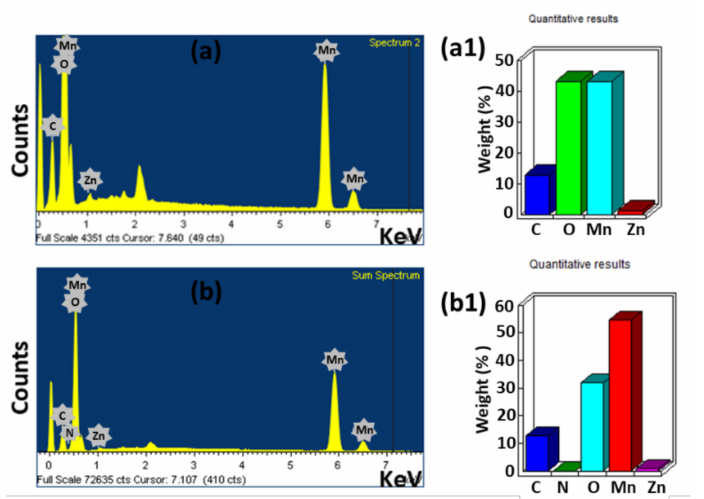
Figure 7. ( a ) EDX spectra of (1%) ZnO–MnCO 3 sample, ( a1 ) quantitative analysis of (1%)ZnO– MnCO 3 sample, ( b ) EDX spectra of (1%)ZnO–MnCO 3 /(1%-NDG) sample, ( b1 ) quantitative analysis of (1%)ZnO–MnCO 3 /(1%-NDG)